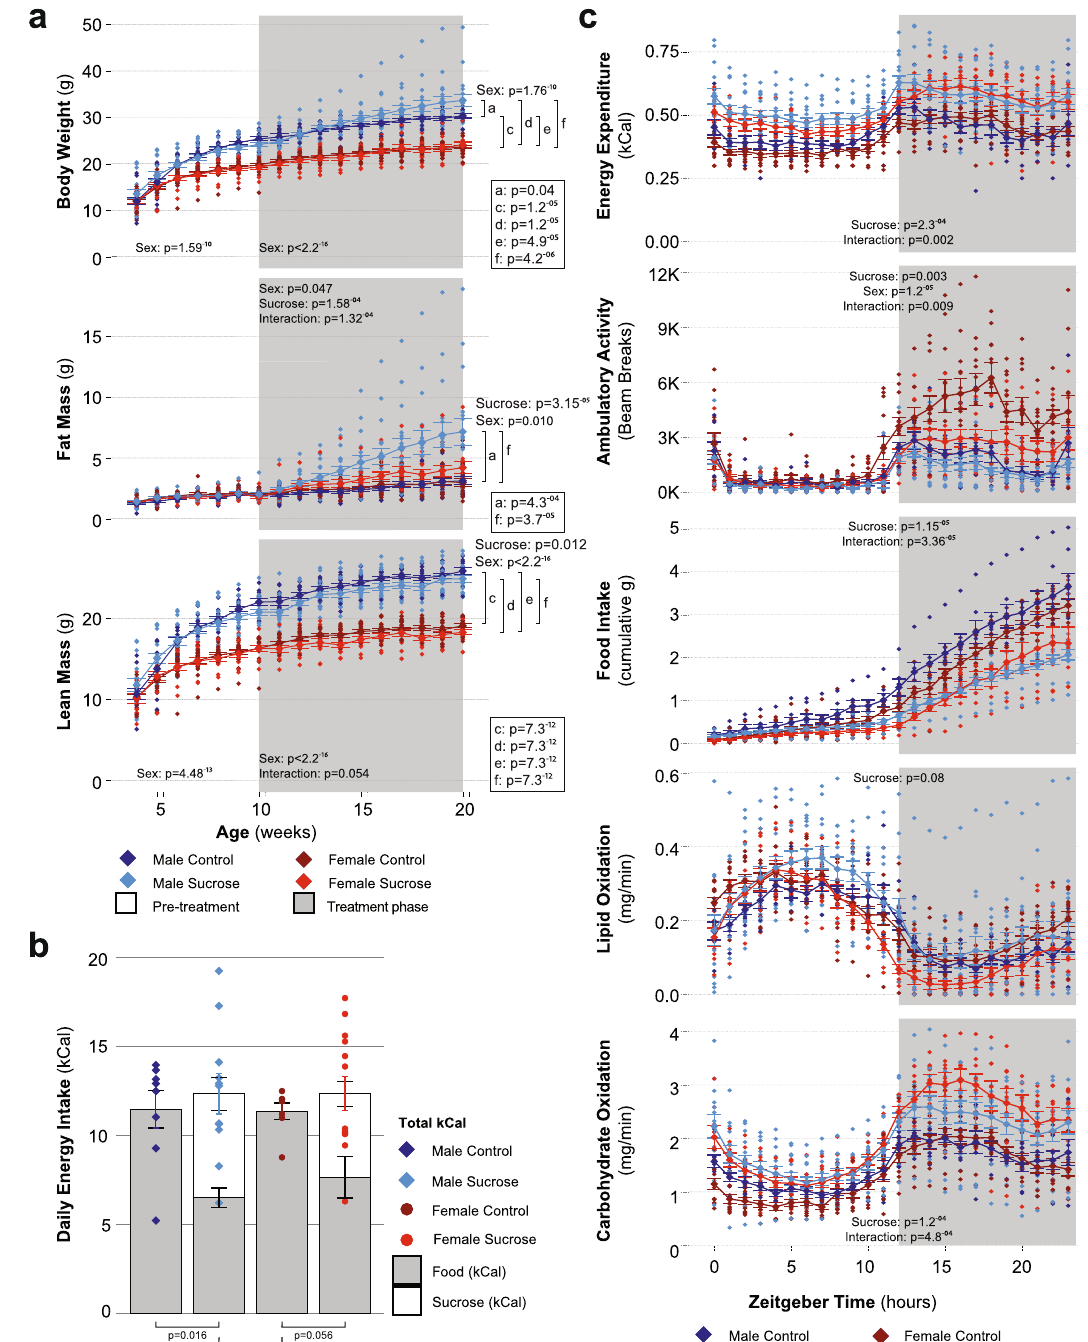
Fig. 1 | Sucrose intake modulates macronutrient metabolism and storage. a Longitudinaleffectsofsucroseintakeontotalbodymass,fatmass,andleanmass as determined by linear mixed effects models with likelihood ratio tests. 20-week (10weekstreatment)datawerelog-transformedandcomparedbytwo-wayANOVA with post hoc Tukey ’ s test (fatand leanmass) or Scheirer – Ray – Haretest and post- hoc Wilcoxon Rank Sum test with continuity correction (body weight; MC: n =15, MS: n =18, FC: n =19, FS: n =13; see fi gure for p -values). b Caloric intake from food was reduced in the sucrose groups as determined by Scheirer – Ray – Hare test and post hoc Dunn analysis with Benjamini and Hochberg correction for multiple